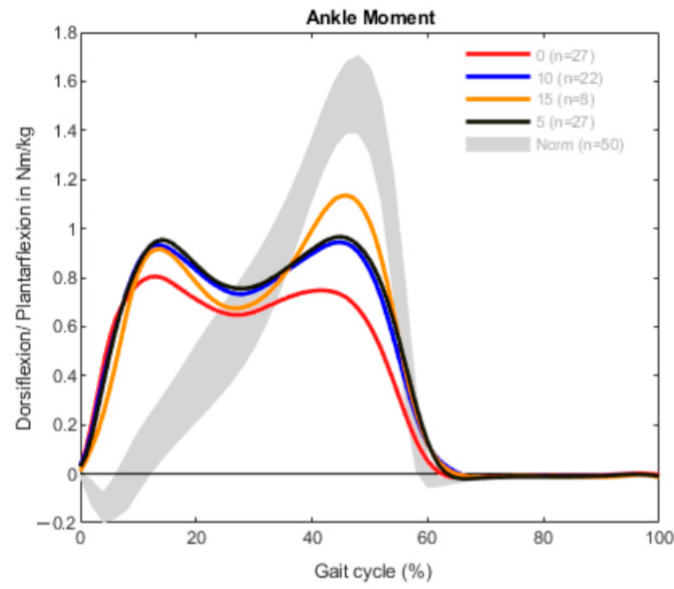
Figure 2. Ankle moment measurement in the bilateral group ( n = 84).